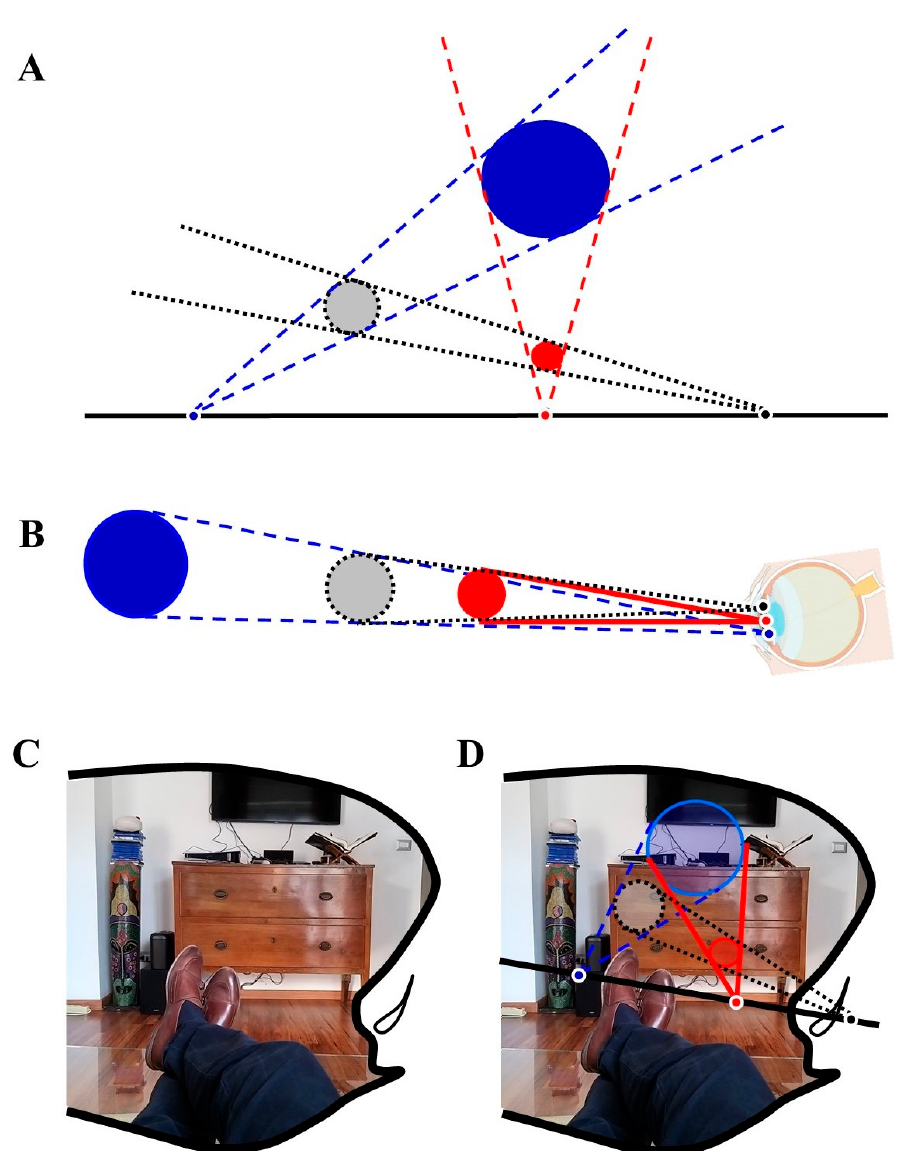
Figure 3. Monge’s theorem (MT) for the evaluation of depth perception. ( A ) Pictorial rendering of MT. ( B ) MT can be used to investigate the physiological mechanism of depth perception. The line on the eye lens corresponds to the line joining the projections from three objects embedded in the environment. ( C ) A subject lying upon his sofa with his right eye closed. “In a frame formed by the ridge of my eyebrow, by my nose and my moustache, appears a part of my body, so far as visible, with its environment” [125]. ( D ) An example of the monocular depth perception of MT drawn from Figure 3C. Three objects with different distances from the eye are projected to a black line on the eye lens, according to the MT rules.